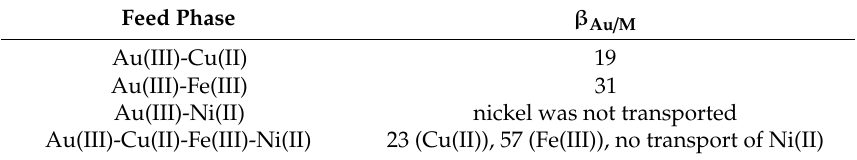
Figure 6. Transport of gold(III) in the presence of Fe(III), Cu(II), and Ni(II). Table 7. Separation factors for the transport of gold(III) in the presence of other